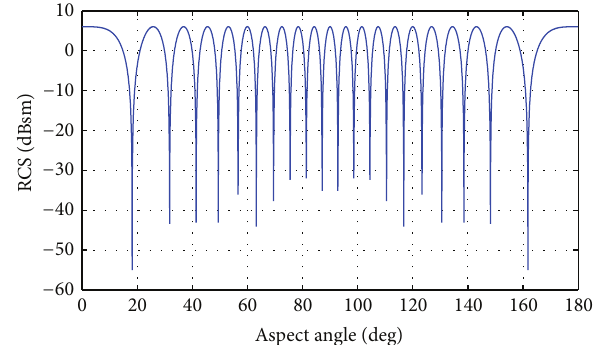
Figure 11: Variation in RCS of two isotropic scatterers with aspect